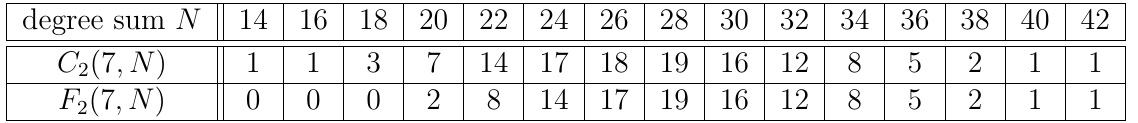
Table 4: Number of potentially (row C graphical degree sequences of length 7 with given degree sum N